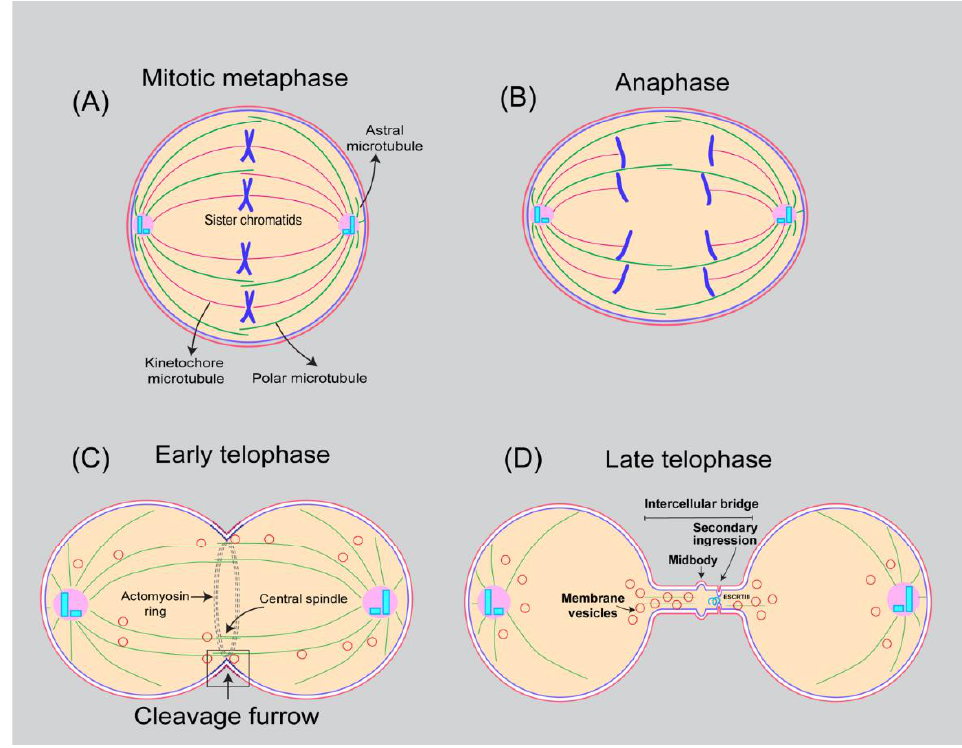
Figure 1. Schematic representation of mitotic cells undergoing division. ( A ) At metaphase, cells acquire round shape, chromosomes attached to kinetochore microtubules become aligned at the equatorial plane. ( B ) At anaphase, cells elongate, sister chromatids separate, and the daughter chromosomes move towards the poles. ( C ) Once daughter chromosomes reach poles and form two nuclei, the cytoplasm between the two nuclei is divided and physically separated by a process known as cytokinesis. During early stages of telophase, the mitotic spindle determines the site of cleavage furrow, by recruiting two master regulators Centralspindlin complex and Chromosomal Passenger Complex (CPC). These multisubunit complexes activate downstream signaling proteins including Rho-GEF (Ect-2), Rho GTPase and cytoskeletal regulators to promote assembly of actomyosin contractile ring (composed of unbranched actin and myosin-II) positioned midway between segregated chromosomes. Plasma membrane at the cytokinetic furrow is anchored to the contractile ring via Anillin and Septins and anionic phospholipid PI(4,5)P 2 . Constriction of the ring with concomitant membrane addition via both endocytosis and forward trafficking, generates the cleavage furrow. ( D ) Cleavage furrow ingression and stabilization results in the formation of intercellular bridge with an electron dense structure in the middle called midbody. The final steps of cytokinesis known as abscission involve endocytic trafficking, clearance of PIP2 on furrow membrane, microtubule severing, F-actin clearance, fusion of endosomes with the plasma membrane leading to secondary ingression. In a final step, there is assembly of the endosomal sorting complex required for transport (ESCRT III) helical filaments downstream of Cep55 and ALIX-TSG101 activation, resulting in membrane cutting that will physically separate the cytoplasm between two daughter cells.